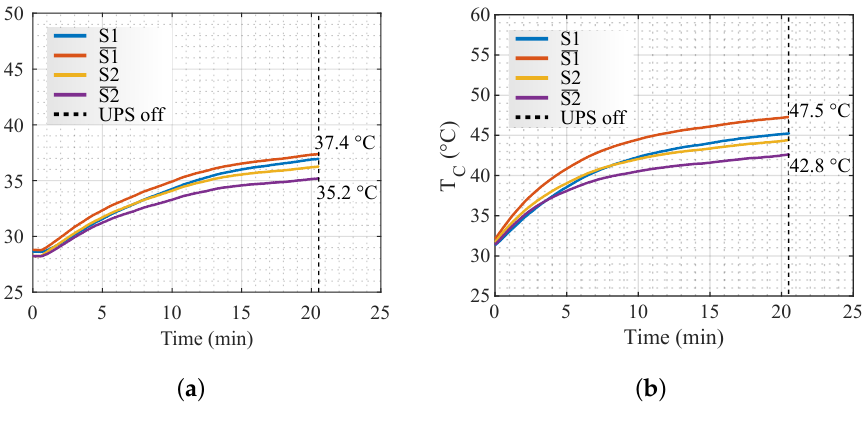
Figure 5. Temperatures measured in the MOSFETs [11]. ( a ) 400 W. ( b ) 600